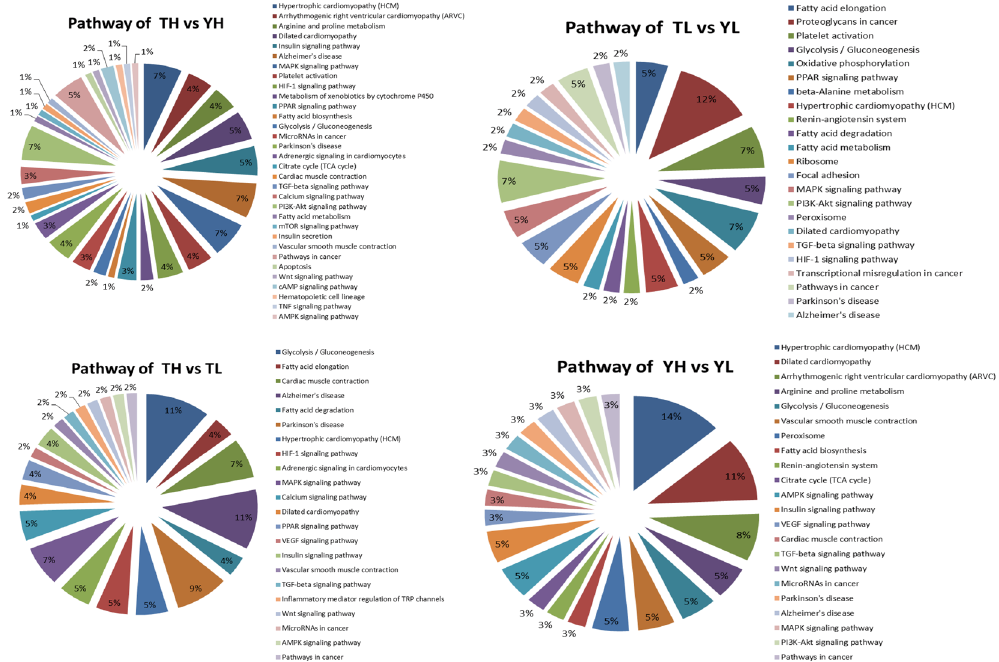
Figure 2. Differentially expressed protein (DEP) pathway analysis. TH, Tibetan highland pig; TL, Tibetan lowland pig; YH, Yorkshire highland pig; YL, Yorkshire lowland